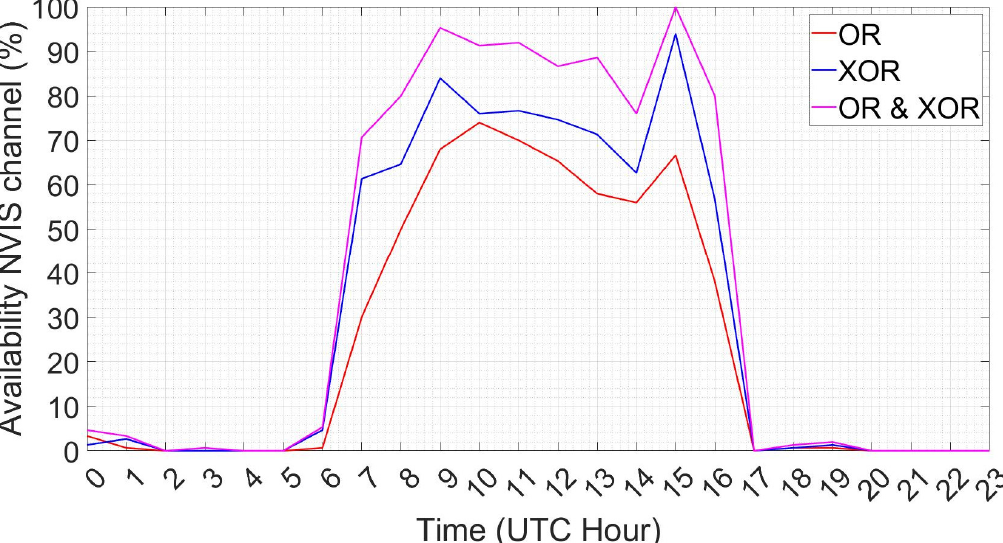
Figure 4. NVIS link availability depending on solar activity and the ionosphere’s state [11]. The graph’s legend is defined as follows: OR refers to the performance of the ordinary wave, XOR refers to the performance of the extraordinary wave received. OR and XOR refer to the total performance between both the ordinary and extraordinary modes. We have the copyright of [11], it belongs to the GRITS research group from La Salle.